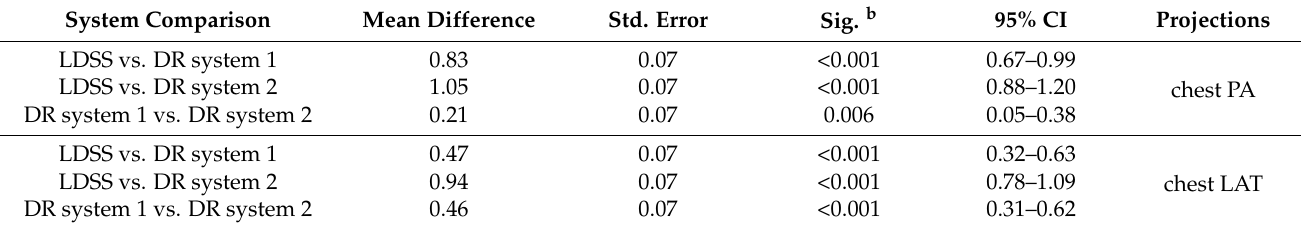
Table 11. Comparison of the mean VGA across the imaging systems in chest PA and LAT protocol.